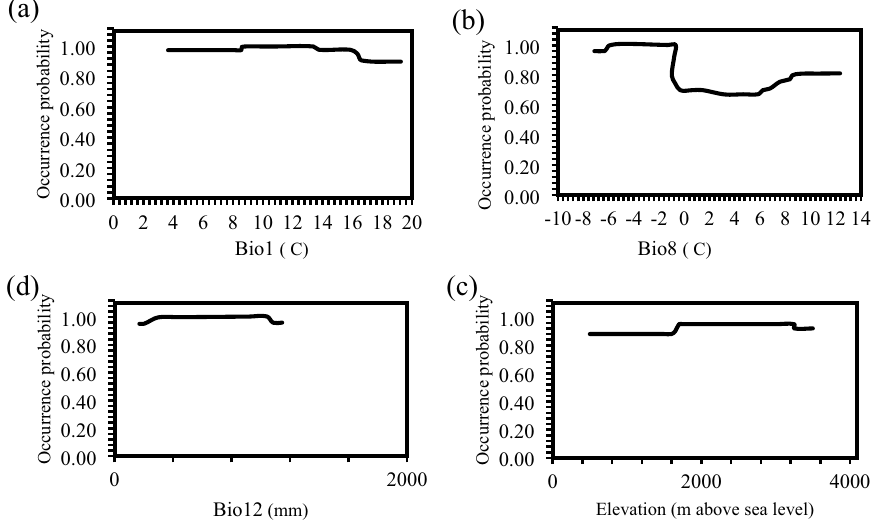
Figure 4. Response curves for the three Bioclimatic ( a – c ) and one topographic ( d ) layers used in the RF algorithm for S. inflata. See abbreviations as in Table